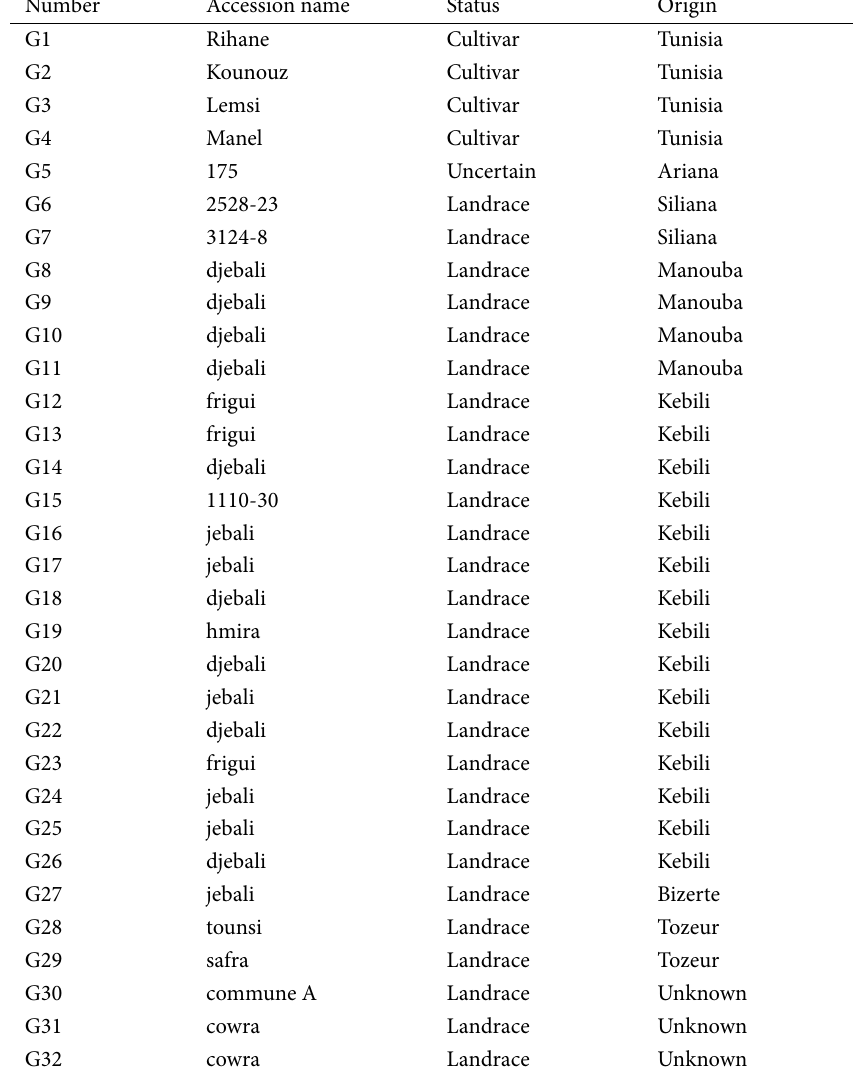
Table 1 A list of the 32 Tunisian barley accessions used for phenotyping.